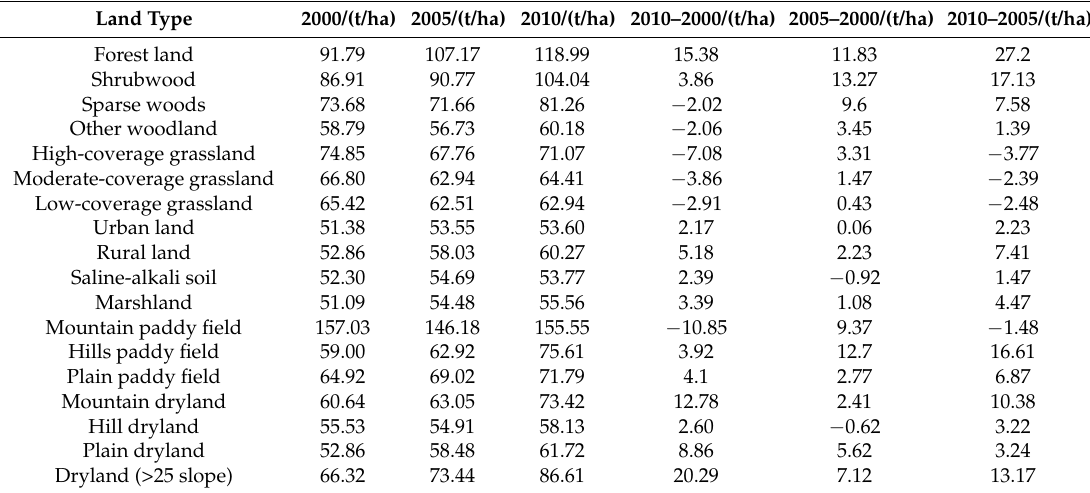
Table 1. The carbon density of different land use types and changes in carbon density during 2000–2010.